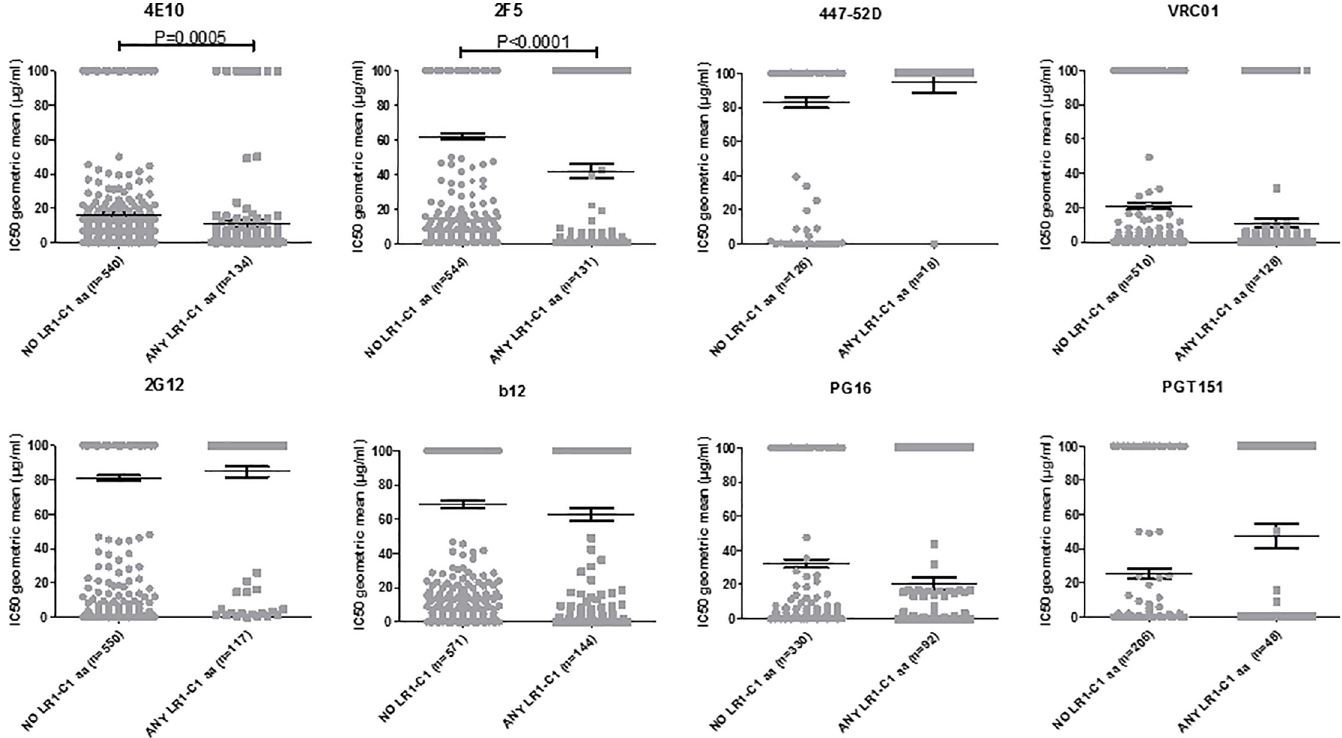
Fig 4. Neutralization sensitivity to bNAbs of viral isolates with 4E10-selected aminoacids. Graphical plot showing the comparison of neutralization sensitivities to several bNAbs of viruses from neutralization HIV-1 database (http://hiv.lanl.gov/catnap) with any of the aminoacid replacements incorporated by LR1-C1 that are indicated in Table 2 (closed grey squares) and with none of the aminoacids incorporated by LR1-C1 (closed grey circles). HIV-1 isolates with Y131, W503 and N643 aminoacids were not included in the analysis because there was no neutralization data or no isolate with this mutation in the database. Mann-Whitney U test was used for comparisons of continuous variables between groups. Simple comparisons were made with the use of a two-sided alpha level of 0.05.